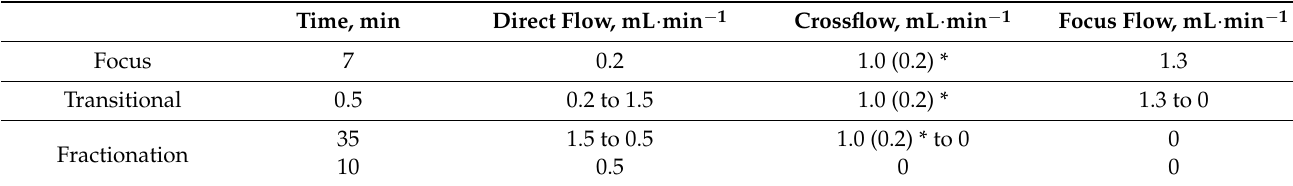
Table 1. Flow program used for silver nanoparticle (AgNP) analysis by AF4. Detection flow: 0.5 mL · min − 1 . * For assays to study the polydispersity of the aggregated AgNPs. For more explanations see text. Time, min Direct Flow, mL · min − 1 Crossflow, mL · min − 1 Focus Flow, mL · min − 1 Focus 7 0.2 1.0 (0.2) * 1.3 Transitional 0.5 0.2 to 1.5 1.0 (0.2) * 1.3 to 0 35 1.5 to 0.5 1.0 (0.2) * to Fractionation